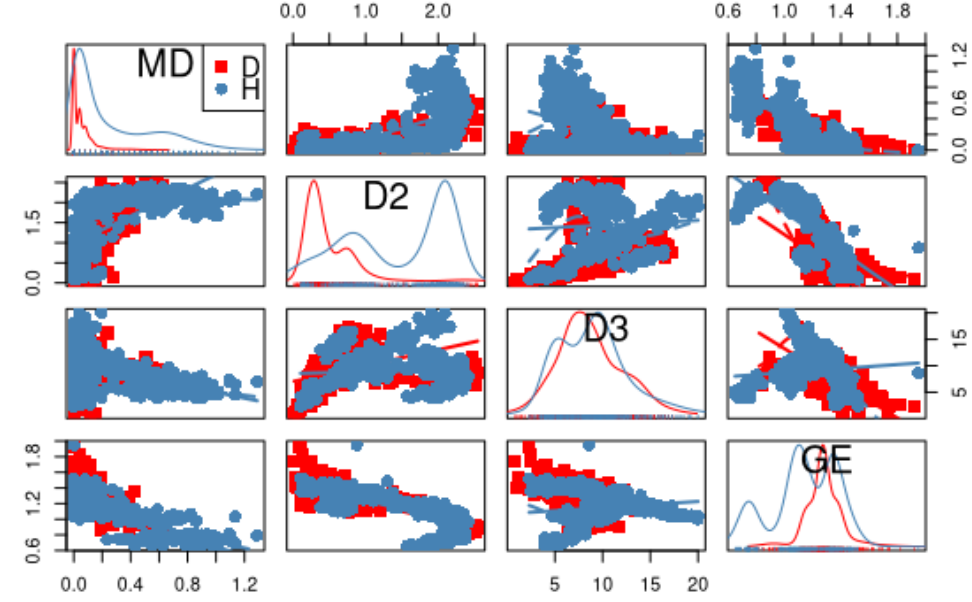
Figure 5. Features correlation on MD, D2, D3, and GE for eyes-open status. It can be seen that the depression group’s results are lower than those of the health group for MD, D2, and GE.